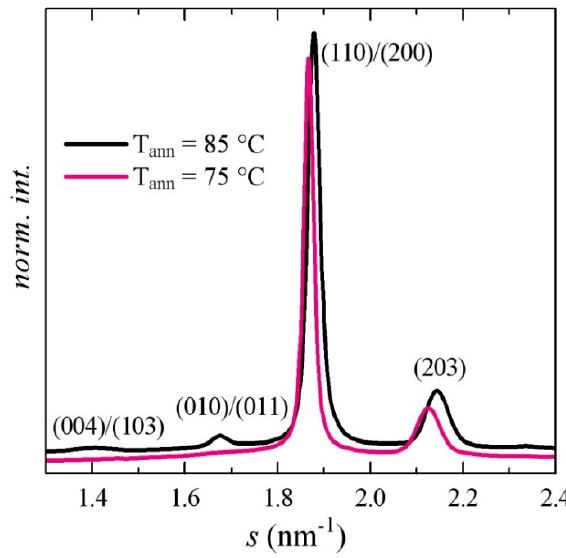
Figure 11. Synchrotron X-ray diffraction patterns at room temperature for PLA after crystallization for 8 h from the glassy state at the indicated temperatures. The Miller indices are indicated.